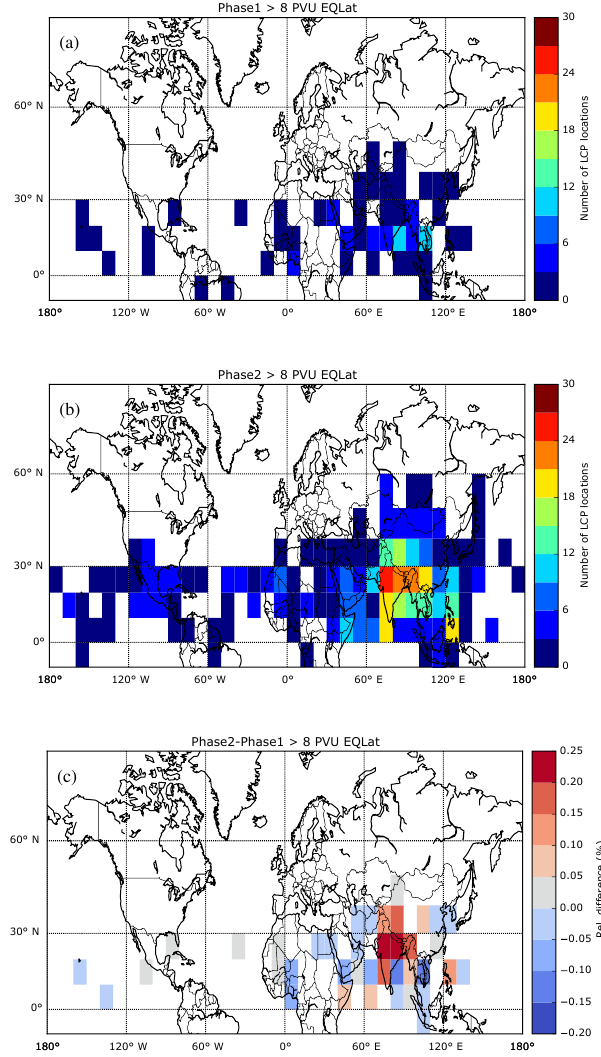
Figure 6. Location of Lagrangian cold point (LCP) binned by longi- tude and latitude. LCP locations for phase 1 and phase 2 are shown in (a) and (b) , respectively. The relative difference normalized to the total number of trajectories is shown in (c) .